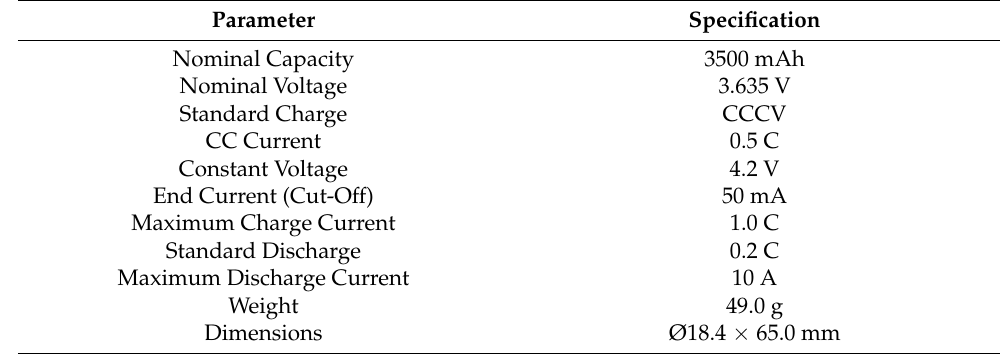
Table 1. Characteristics of the tested cell (INR18650-MJ1) from the manufacturer (LG Electronics, South